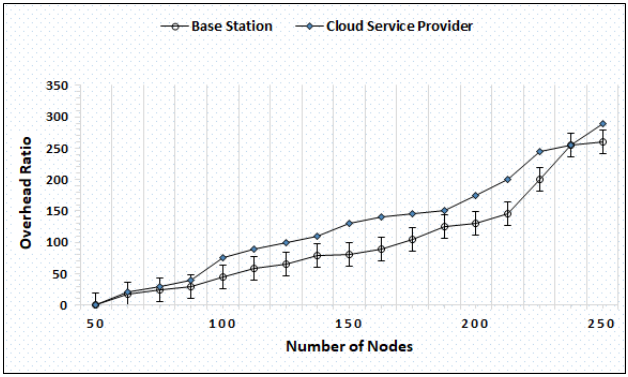
Figure 5. Overhead ratio evaluation by varying